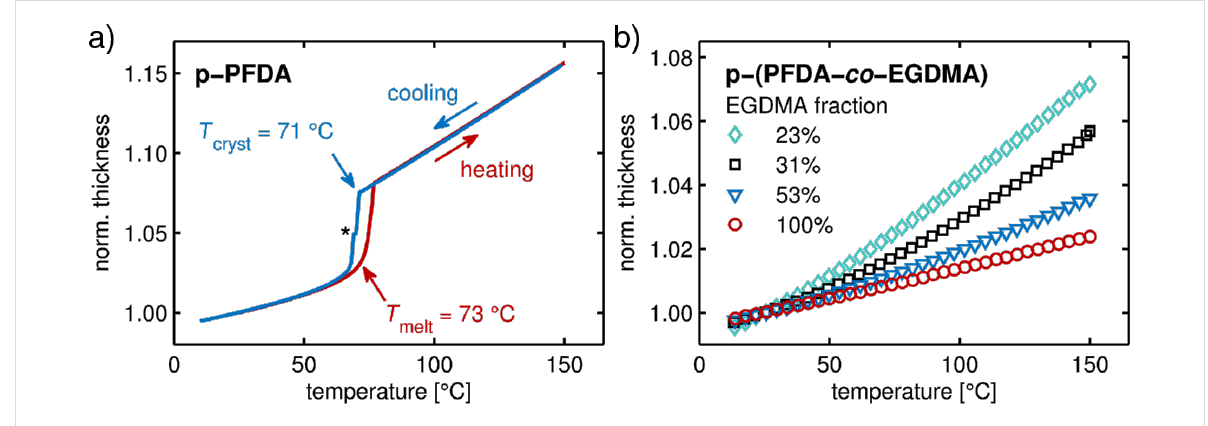
Figure 6: In situ spectroscopic ellipsometry data depicting film thickness evolution as a function of temperature for a PFDA homopolymer (a) and for samples containing different degrees of EGDMA cross-linking (b). The heating/cooling rates were 5 °C/min and data are normalized to the thickness at 25 °C. The data in (b) has been reduced for clarity and only cooling runs are shown. Please note that the discontinuity in (a) is an artefact and has been marked by an